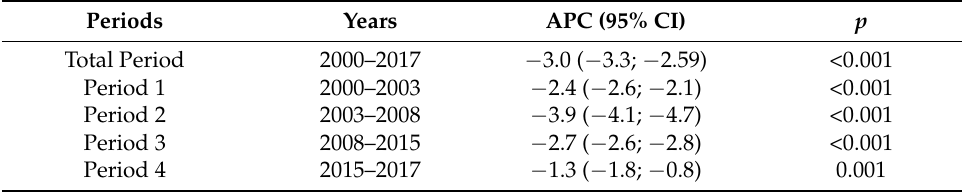
Table 1. Joinpoint analysis for maternal mortality rates in Africa, 2000–2017.